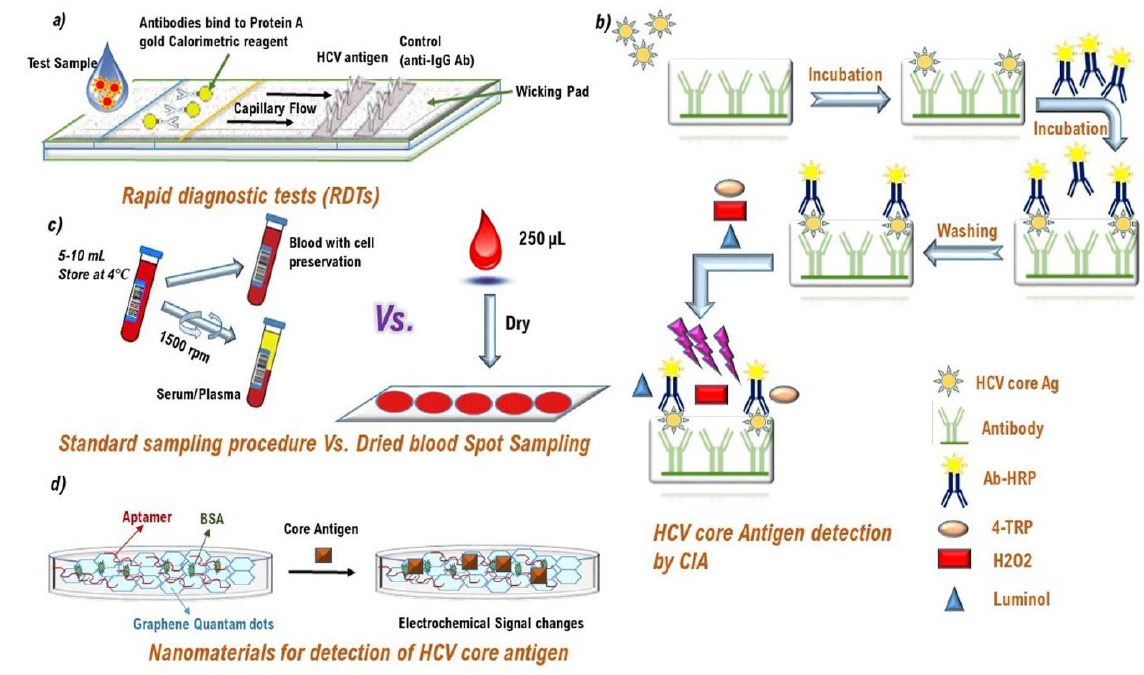
Figure 3. The working principles of currently used HCV screening and diagnosis platforms by detecting anti-HCV Abs, cAg, and RNA. HCV enzyme immunoassays (EIA) are used in three categories to detect HCV antibody, HCV core antigen, or multiple HCV antigen detection. ( a ) depicts the principle of anti-HCV antigen detection by a rapid diagnostic test platform while ( b ) deciphers the principle of HCV core antigen detection by CIA. ( c ) illuminates the advantages of HCV dried blood spot sampling over standard sampling procedure for hepatitis C screening. ( d ) demonstrates the significance of nanomaterials for the detection of HCV core antigen. IgG = immunoglobulin G, BSA = bovine serum albumin, Ab-HRP = Antibody horseradish peroxidase, H 2 O 2 = hydrogen peroxide, ClA = chemiluminescence assay.